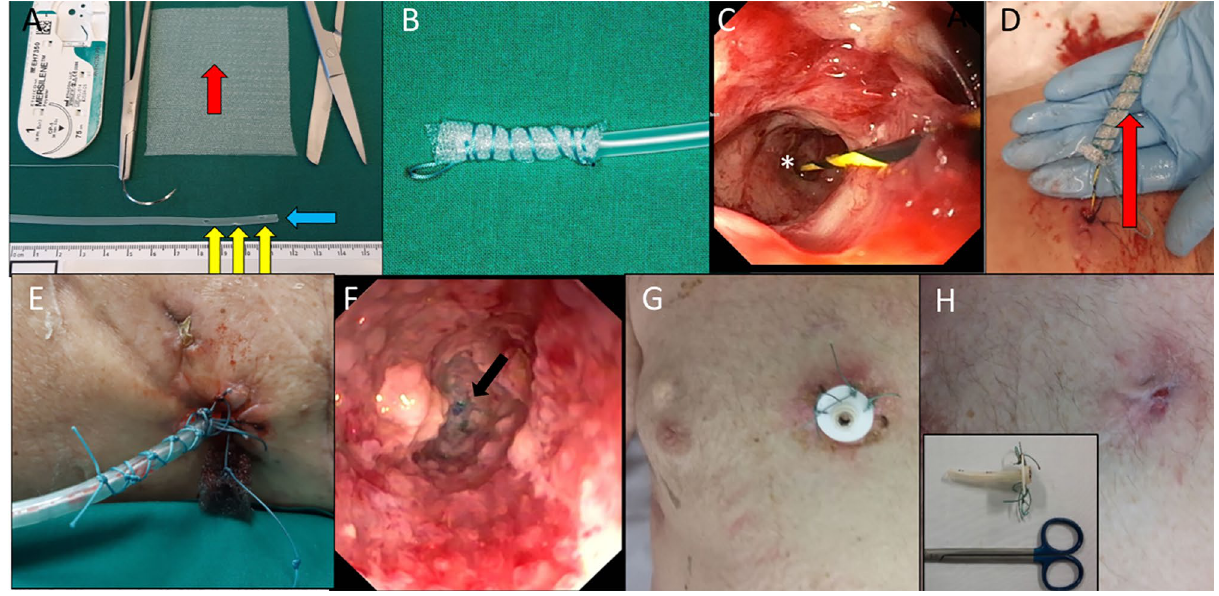
Figure 4. ( A ) A small diameter catheter prepared with several side- (yellow arrows) and end whole (blue arrow) is covered with a segment of open-pore film (red arrow, Suprasorb-CNP, Lohmann & Rauscher, 56,579 Rengsdorf, Germany). ( B ) Open-pore film drainages in (12 Charrière, 4 cm length). ( C ) The tip (*) of a guide wire is placed on the ground of the fistula tract. ( D ) After fistuloscopic measurement of the length with